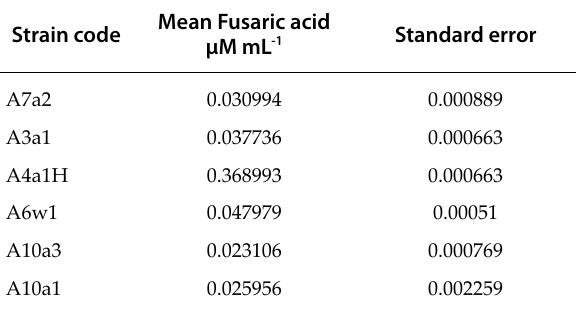
Table 5. Fusaric acid production by isolates of Fusarium proliferatum from garlic ( A. sativum